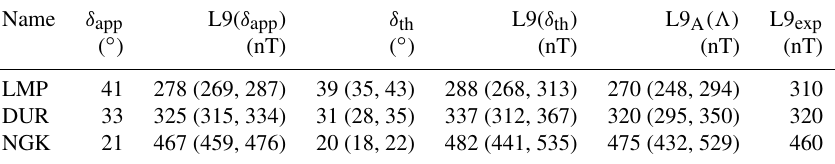
Figure 5. (a) Frequency distributions of (cid:49) K = K NGK − K DUR for L9 = 320nT and, for comparison, the frequency distribution of (cid:49) K = K NGK − K DUR for L9 = 350nT. (b) (cid:49) K = K NGK − K LMP (L9 = 310nT). Table 2. L9 estimated by different procedures; δ app = 69 ◦ − λ (approximate angular distance from the auroral region); L9( δ app ) obtained from δ app using the linear fit in Fig. 8; δ th ( δ estimated from AACGM latitude and the linear fit in Fig. 9); L9( δ th ) obtained from δ th using the linear fit in Fig. 8; L9 A ((cid:51)) obtained from a correction procedure on the key parameter δ(λ) explained at the end of Sect. 3.2. The 95% confidence intervals are also indicated. The last column reports L9 experimentally determined by our calibration procedure.